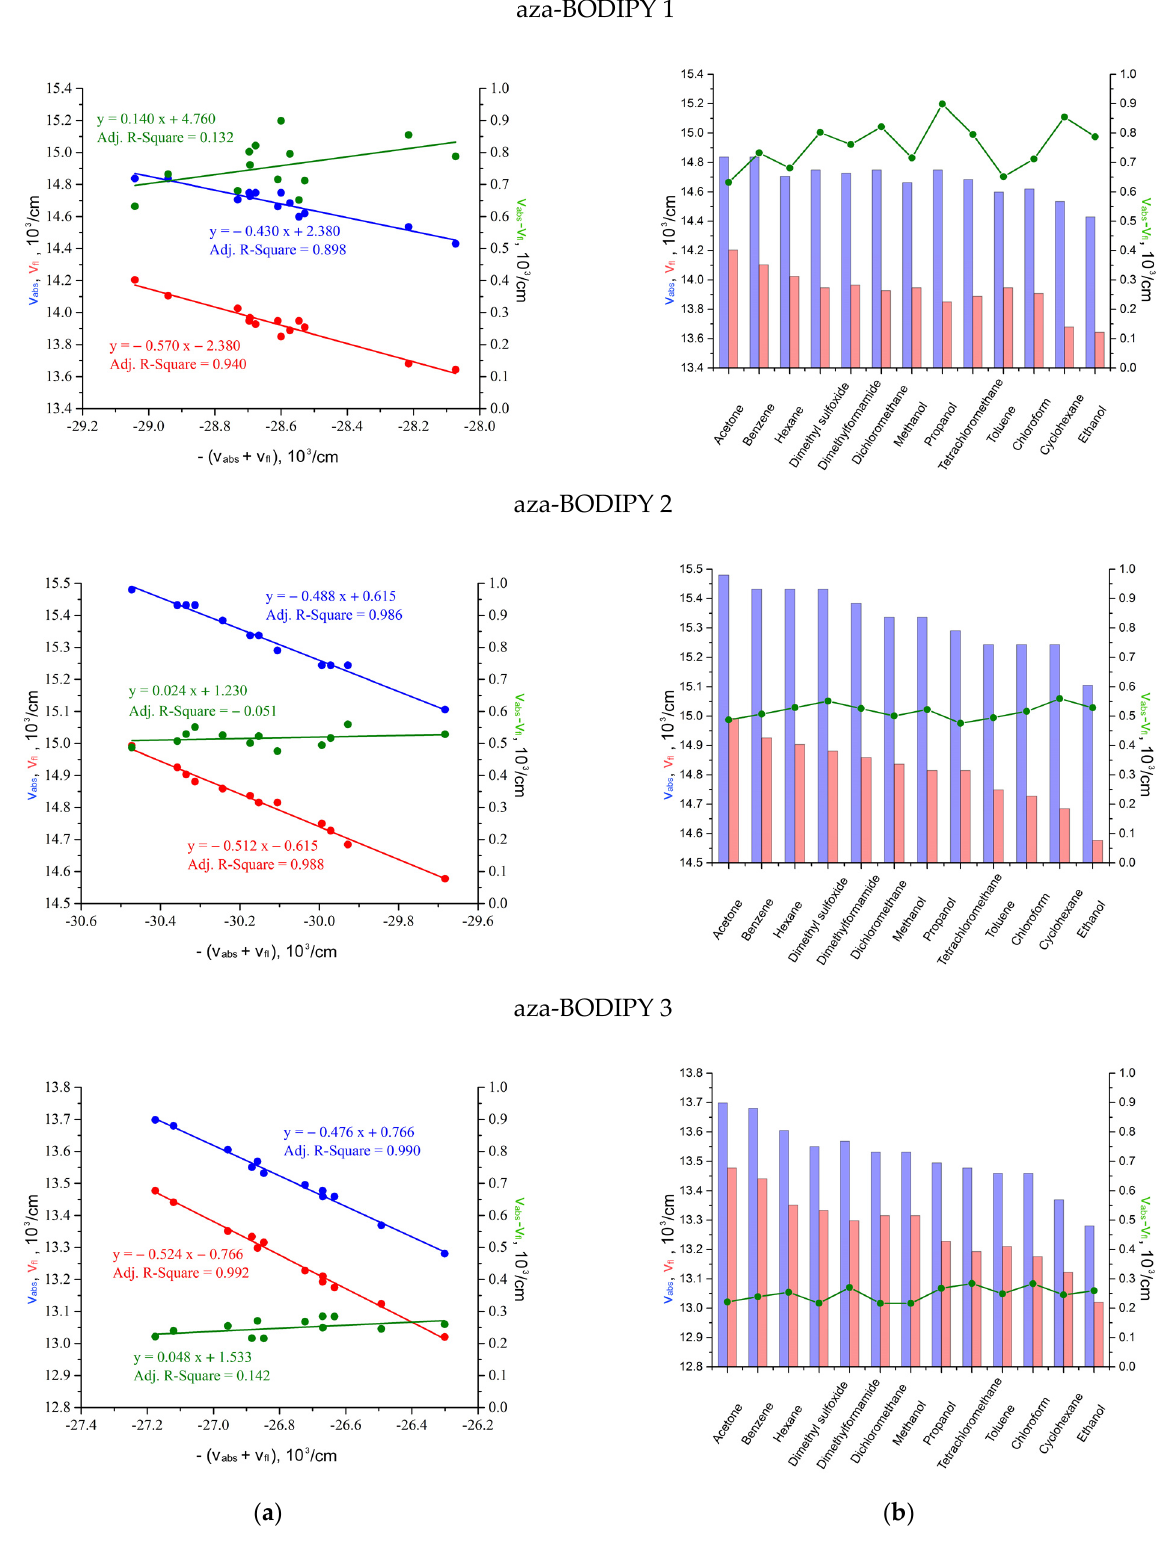
Figure 4. Dependences of the wavenumbers of the Stokes’ shift ν Abs − ν Fl , absorption maxima ν Abs and fluorescence ν Fl on ( a ) negative sum ν Abs + ν Fl ; ( b ) individual organic solvents to determine the solvatochromic sensitivity parameters A, A abs , and A fl . Table 4. Solvatochromic sensitivity parameters.